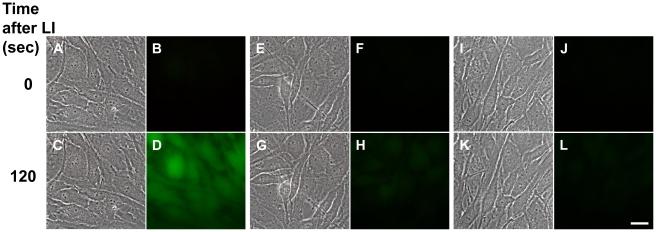
Sodium azide and trolox inhibit the increase of intracellular ROS level after PDT with compound 5.The C6 glioma cells were loaded for 15 min with DCFH-DA and 5 in the absence (A–D) or presence of 10 mM NaN3 (E–H) or 10 µM trolox (I–L). A, C, E, G, I and K, phase contrast; B, D, F, H, J and L, epifluorescence. Images were taken before (upper panel) or after (bottom panel) LI. Note green staining in D and its disappearance in H and L. Bar, 10 µm.